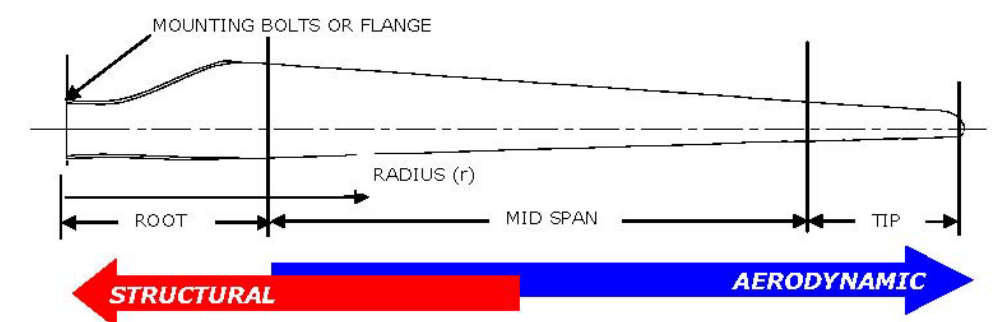
Figure 14. The three blade